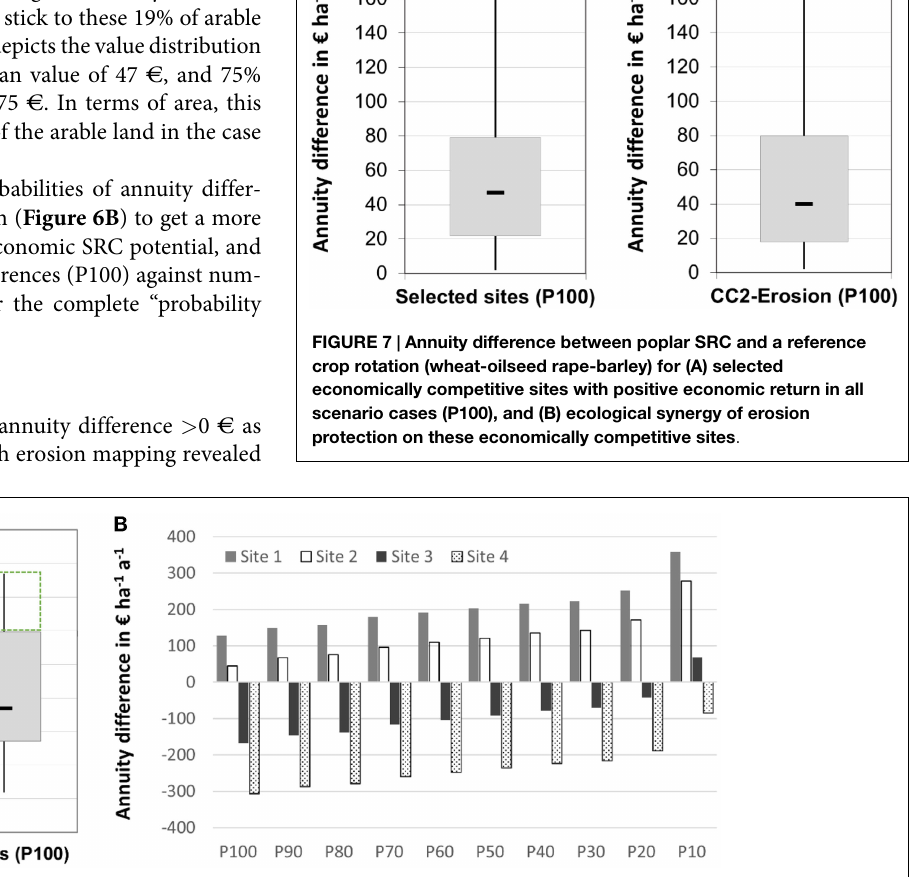
FIGURE 6 | Minimum annuity difference (i.e., the annuity difference that was simulated with a 100% probability – P100) between poplar SRC and a reference crop rotation (wheat-oilseed rape-barley) for (A) all arable sites being subject to the reference crop rotation – dashed green box